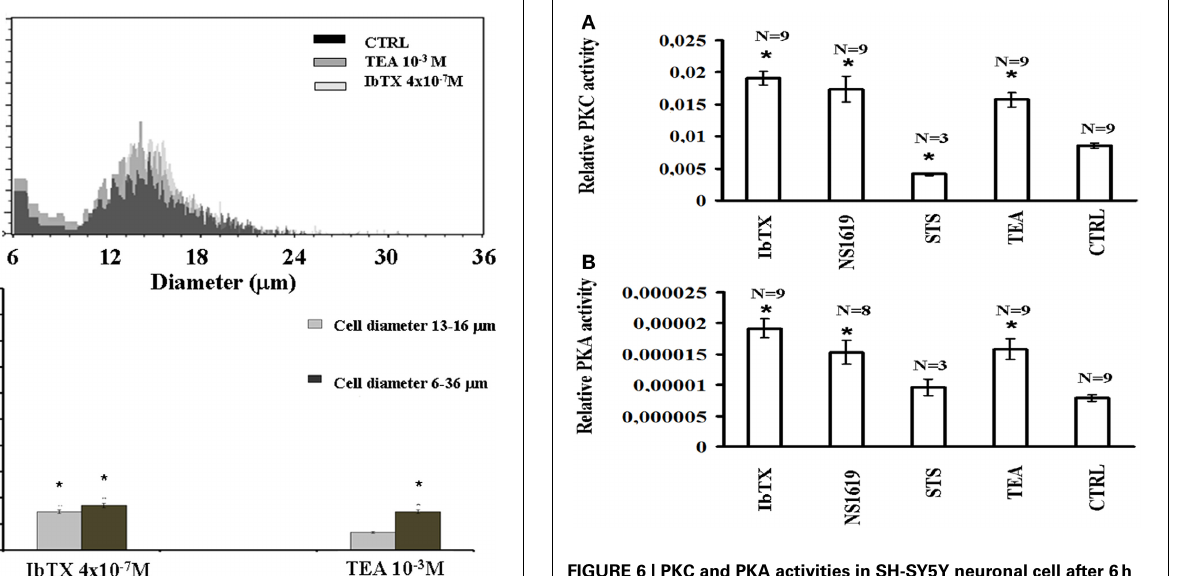
FIGURE 6 | PKC and PKA activities in SH-SY5Y neuronal cell after 6h incubation in the presence of the channel blockers IbTX and TEA and opener NS1619. The effects of the BKCa channel modulators on the protein kinase C (PKC) and protein kinase A (PKA) were investigated in the cell lysate. The cells were incubated with the drugs under investigation for 6h and the cell lysate were analyzed using an ELISA assay for PKC and PKA activities (A) IbTX (10 × 10 − 9 M), TEA (100 × 10 − 6 M), and NS1619 (50 × 10 − 6 M) significantly enhanced PKC activity, while the STS (0.2 × 10 − 6 M) reduced it with respect to the controls (B) TEA, IbTX, and NS1819 enhanced PKA activity, while STS was without effect with respect to the controls. ∗ Data significantly different with respect to the controls for p < 0 . 05 as determined by student t